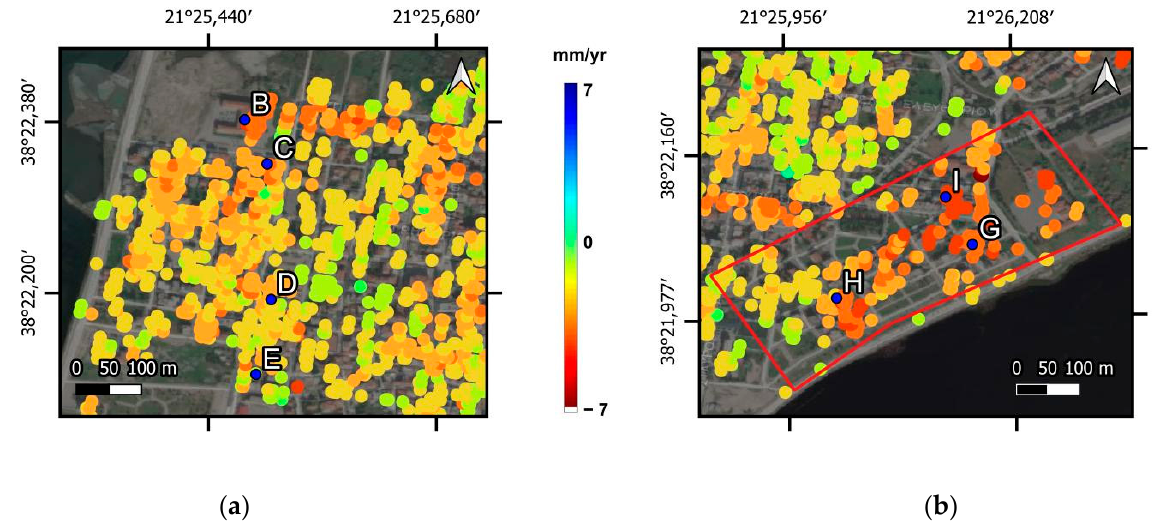
Figure 12. ( a ) West Messolonghi, Locations of buildings with recorded damages. Prefectural Ad- ministration of Aitoloakarnania (B), Port Authority (E) and Public Finance Service of Messolonghi (E) ( b ) East Messolonghi, the area with the most significant deformations (descending satellite pass no. 80). Letters B, C, D, E, H, I and G indicate the location of the buildings where damages were recorded.